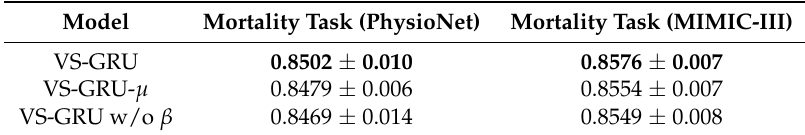
Table 4. Comparison on the missing factor in a single task.